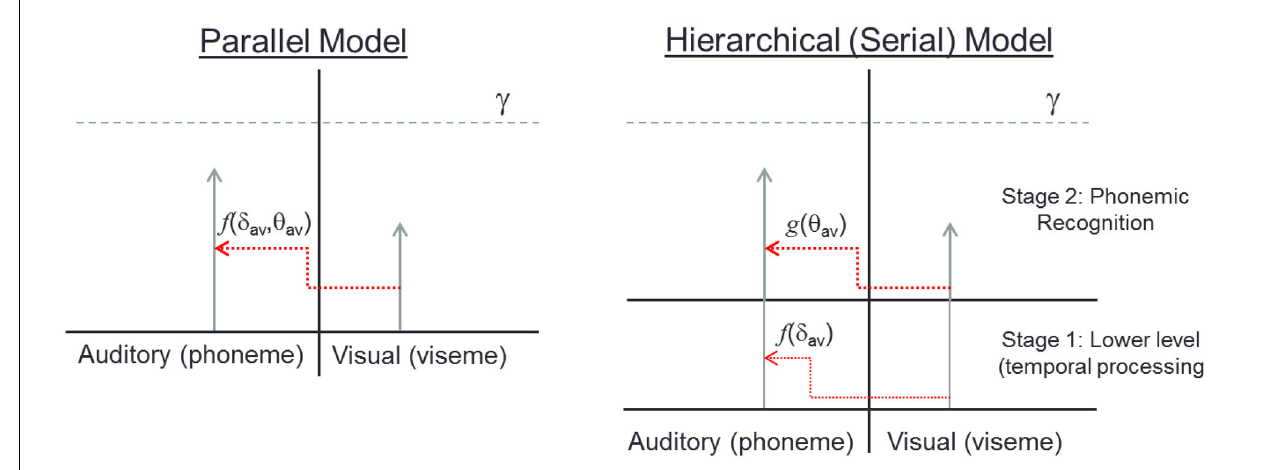
FIGURE 1 | The left panel shows a “parallel accumulator” model with auditory and visual evidence racing toward threshold ( γ ). The amount of visual influence on the auditory signal is a function, f , of parameters δ , and θ which represent temporal coincidence detection and phonetic congruence respectively, both of which contribute evidence to a single accumulator. The